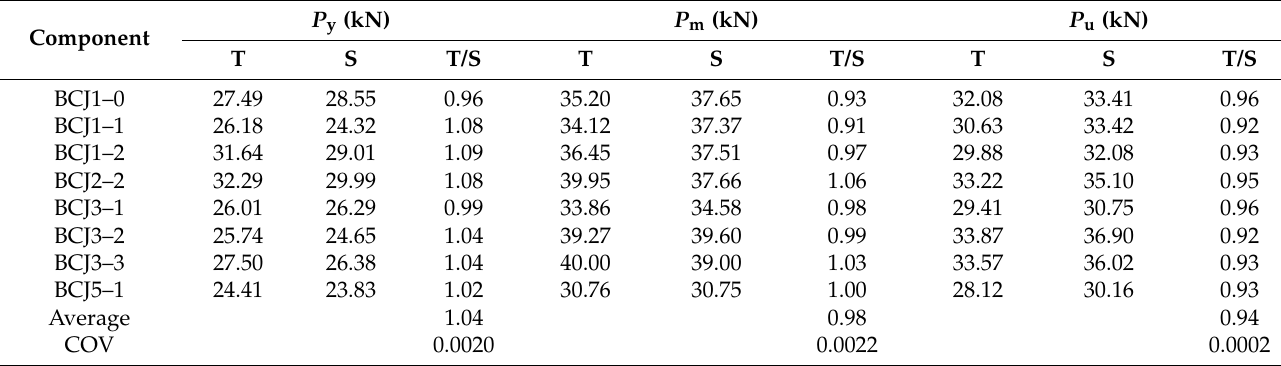
Figure 13. Skeleton curve. Table 4. Comparison of feature